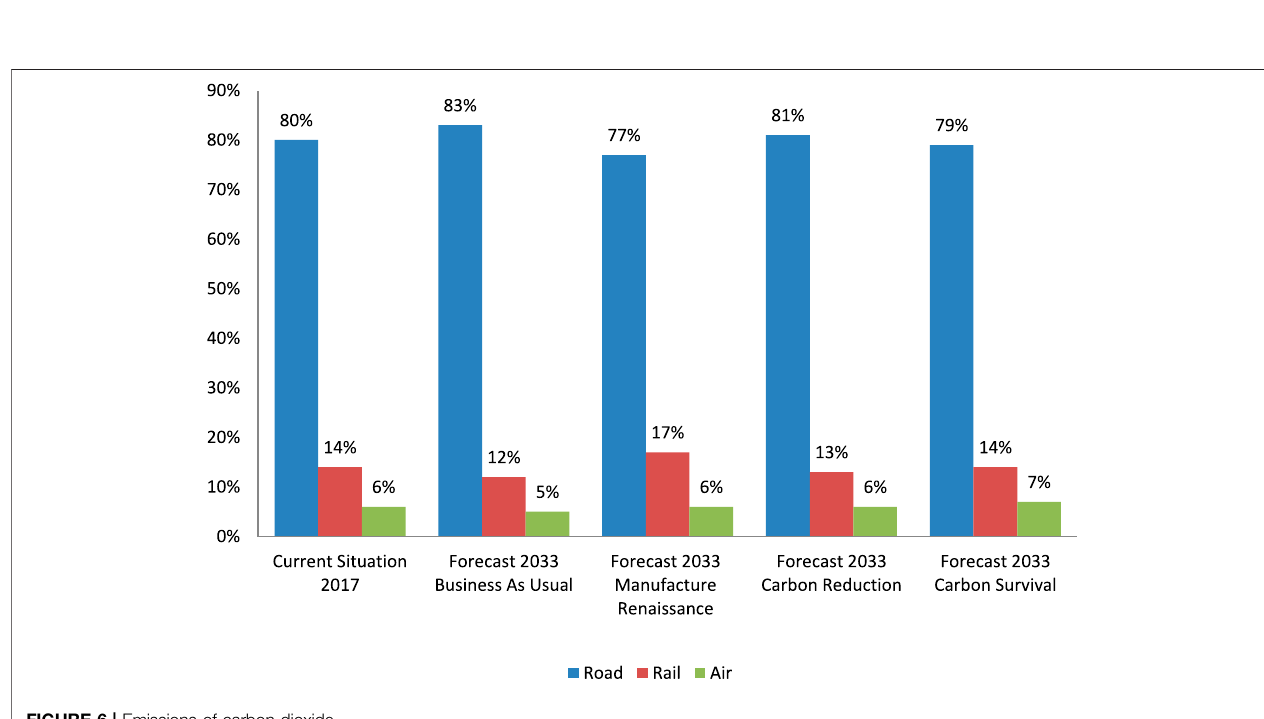
FIGURE 6 | Emissions of carbon